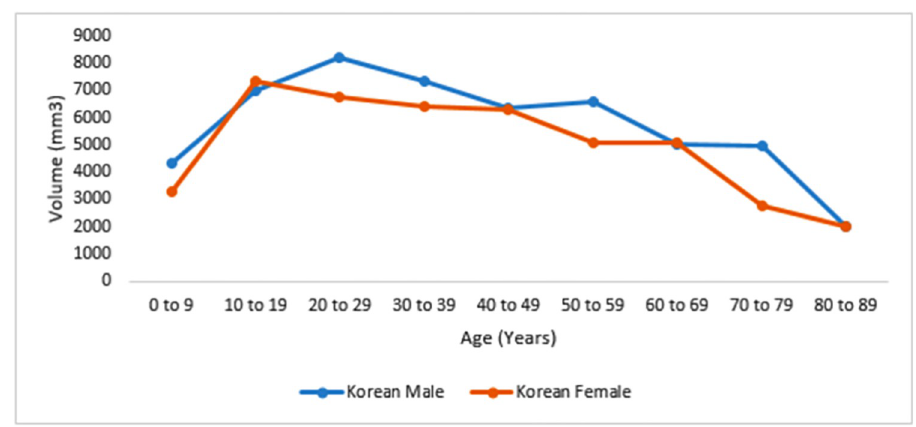
Fig 5. Line graph showing growth rate and size of mastoid air cell systems of study that utilized 10 year age grouping. X-axis displays age range in years, and Y-.axis illustrates the volume of the mastoid air cells.